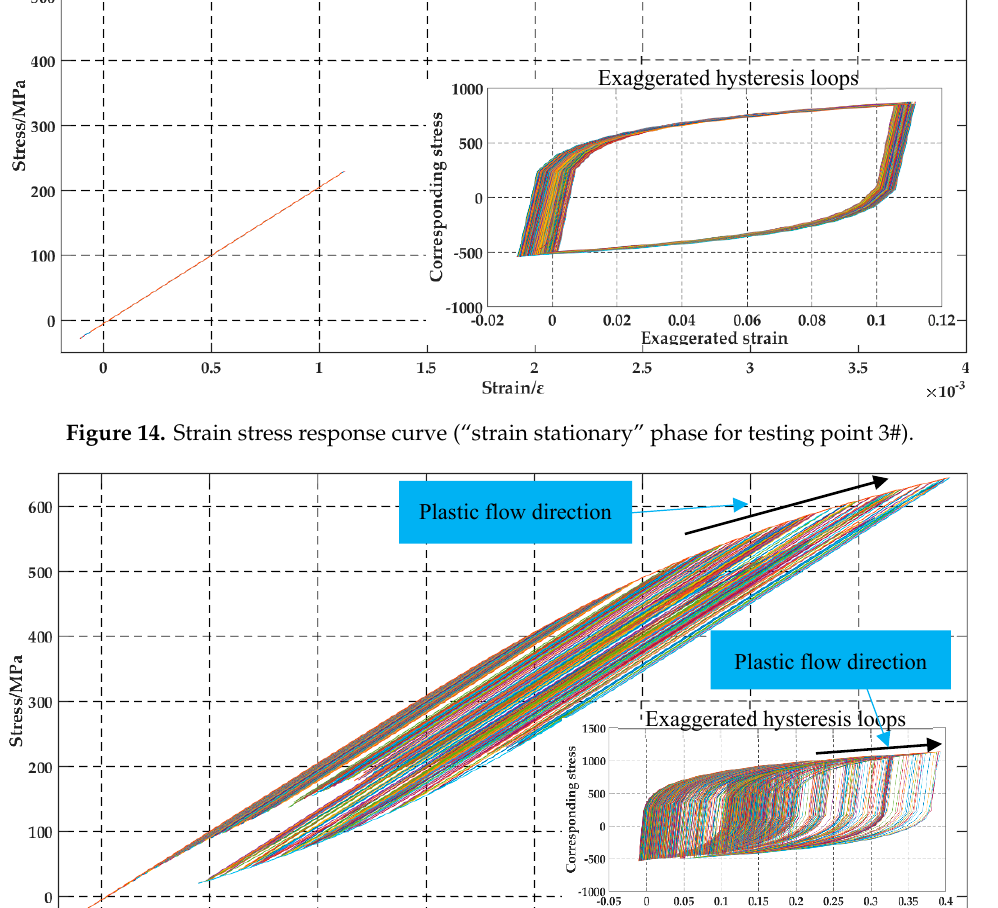
Figure 15. Strain stress response curve (“strain rise and fall sharply” phase for testing point 3#).